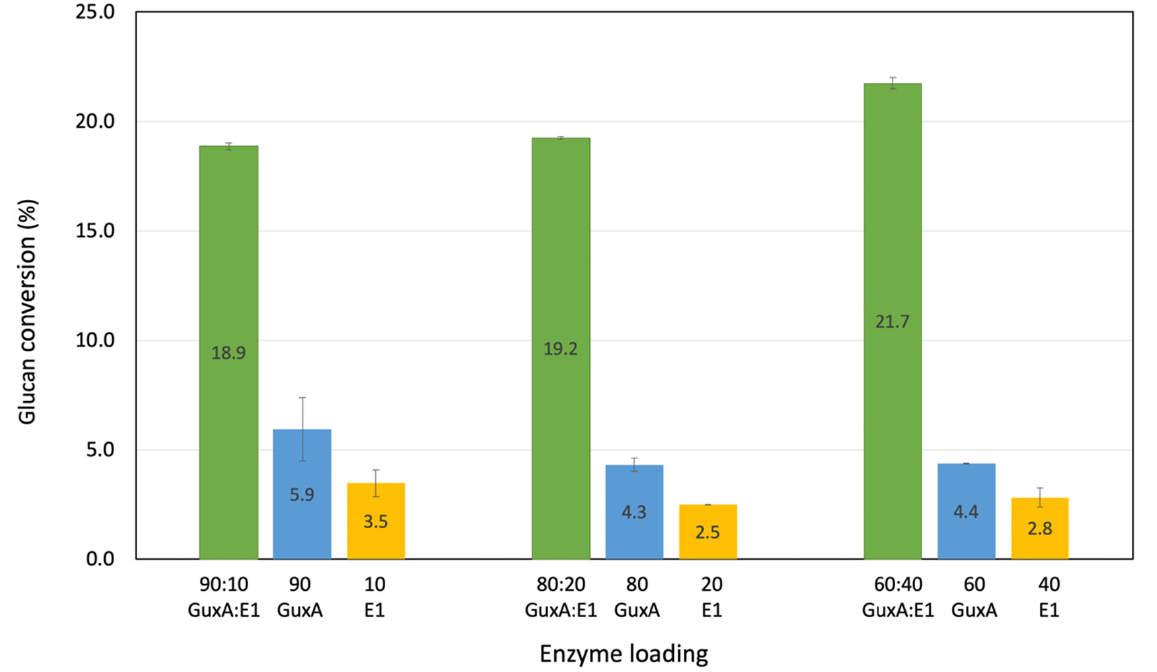
Figure 2. Investigation of the synergistic effects of GuxA with E1 on the deconstruction of Avicel using various mass ratios. Digestions were carried out for 72 h.